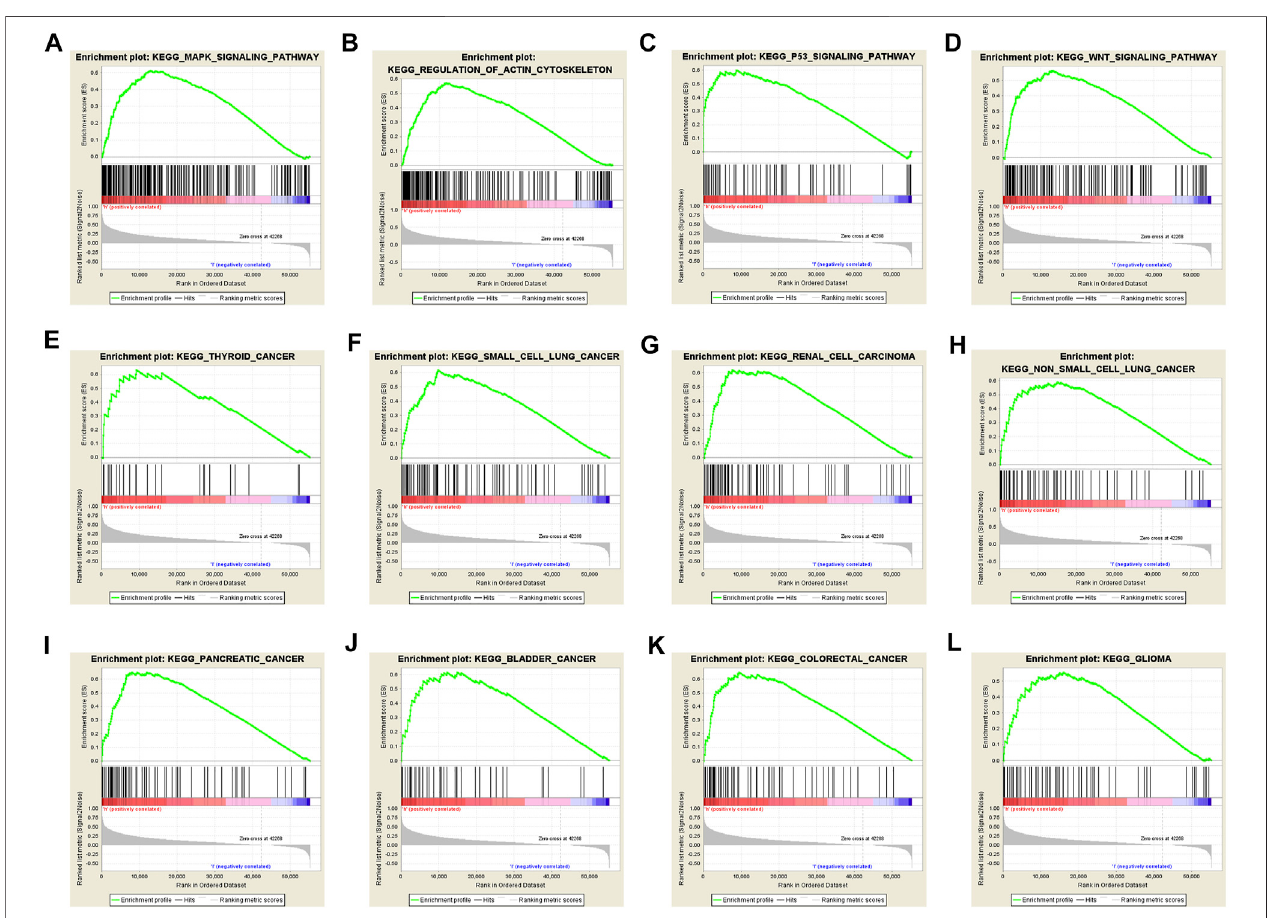
FIGURE 5 | Gene sets enriched in the high DEPDC1B expression phenotype using GSEA 3.0. Panel (A – D) showing some veri fi ed signaling pathways: (A) MAPK signalingpathway (B) regulationofactincytoskeleton (C) p53signalingpathway (D) Wntsignalingpathway;Panel (E – L) showingsomecancer-associatedpathways (E) Thyroid cancer (F) small cell lung cancer (G) renal cell carcinoma (H) non-small cell lung cancer (I) pancreatic cancer (J) bladder cancer (K) colorectal cancer (L)